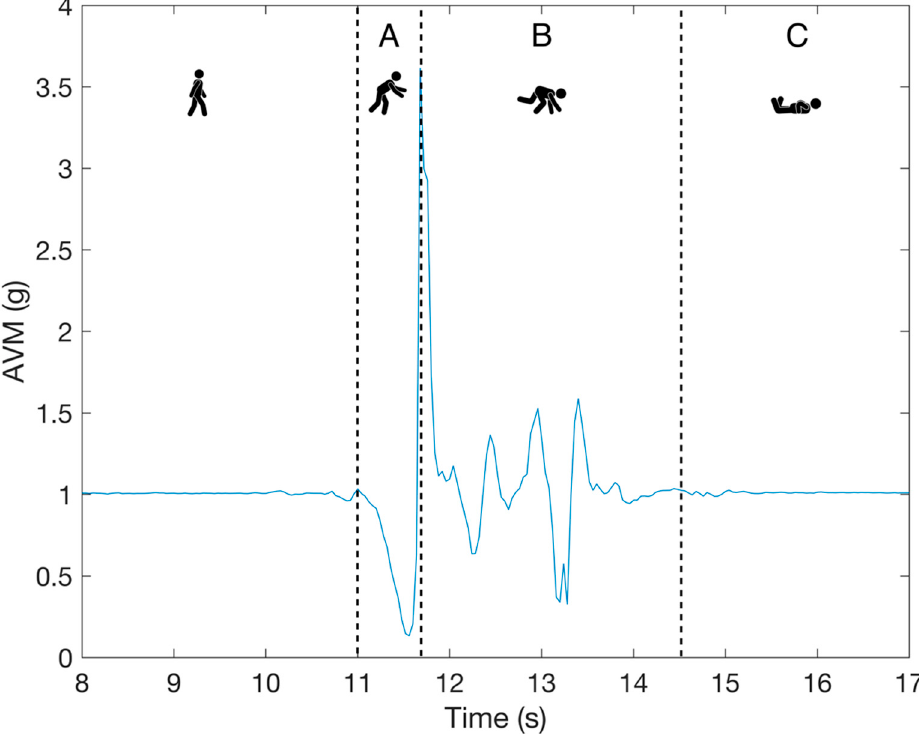
Figure 2. An example of a fall signal with three phases: A is the pre-fall phase, B is the impact phase, and C is the rest phase.